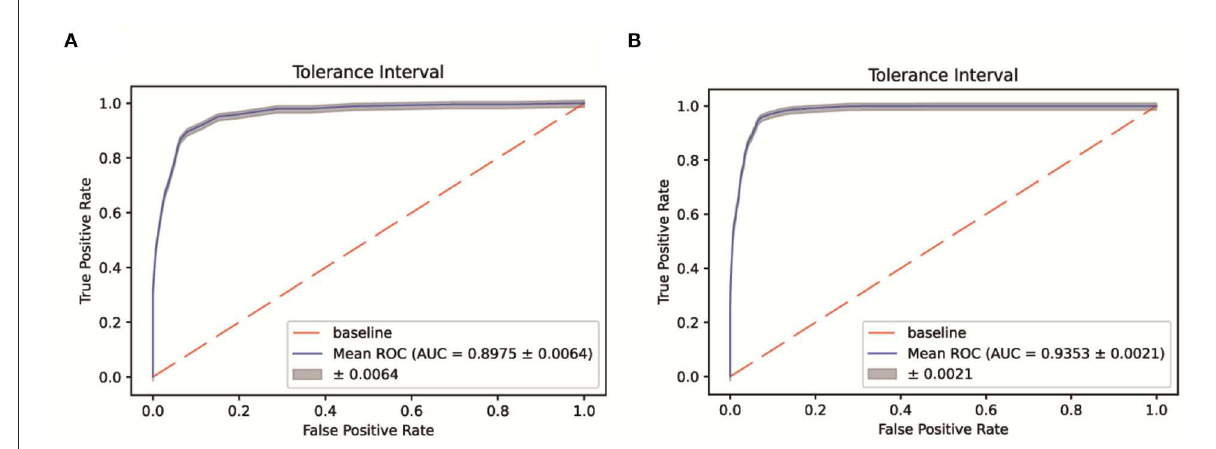
FIGURE4 ROC-AUC of the 7-day (A) and 14-day (B) recovery models based on the SMOTEENN/RF